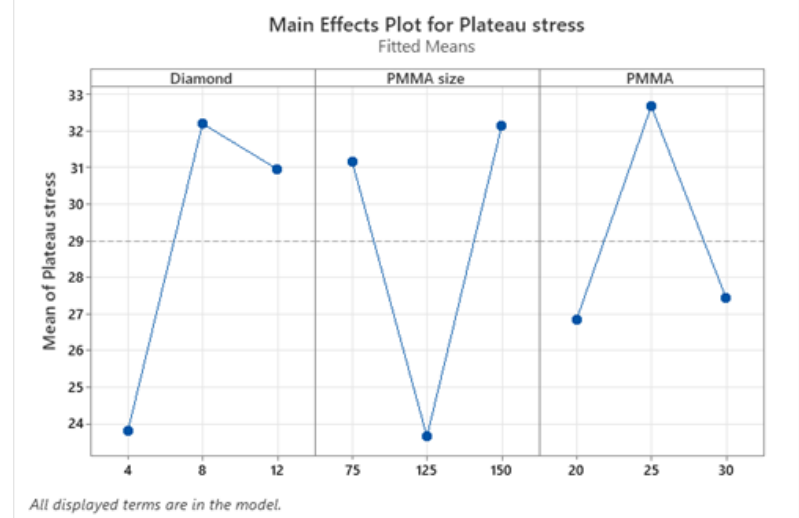
Figure 6. Mean response curve of plateau stress.